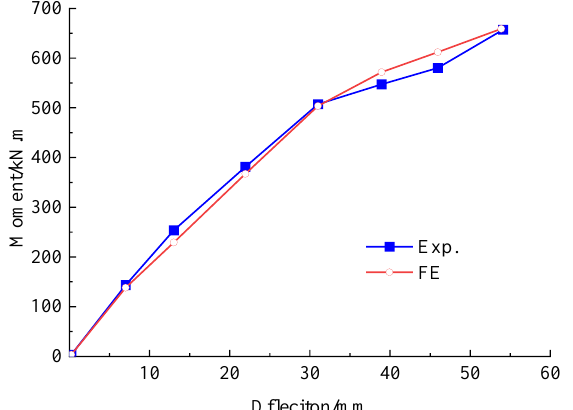
Figure 12. Bending moment versus mid-span deflection curve of the repaired beam under load P 0 .